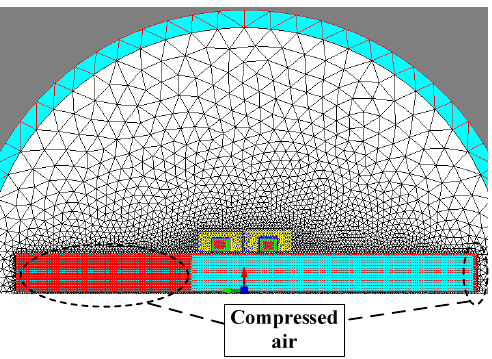
Figure 4. Schematic system of the planar moving induction heating.